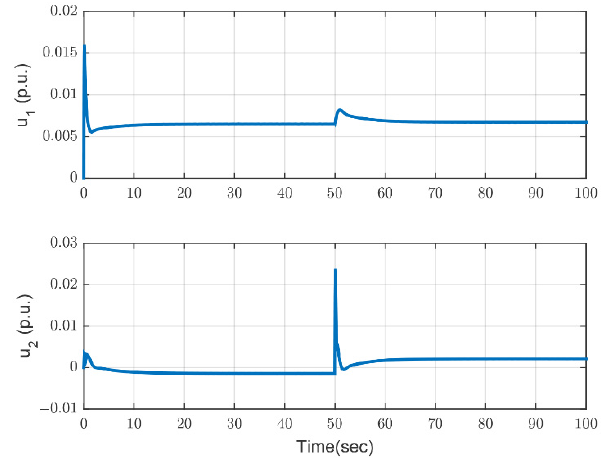
Figure 9. Random load demand change entered to both areas.